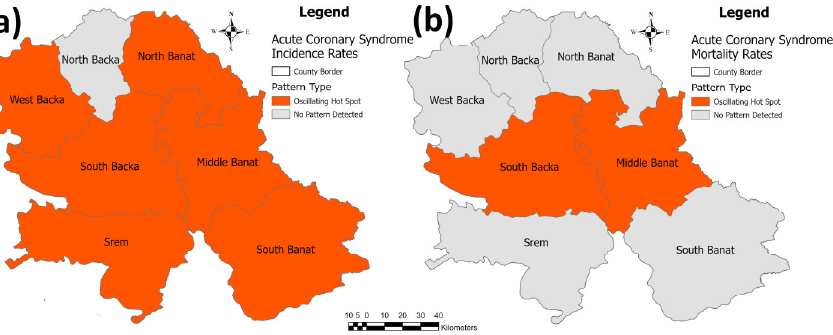
Figure 6. Identified patterns in the emerging hot spot analysis for the acute coronary syndrome incidence/mortality rates per 100,000 population in the province: ( a ) incidence rates, and ( b ) mortal- ity